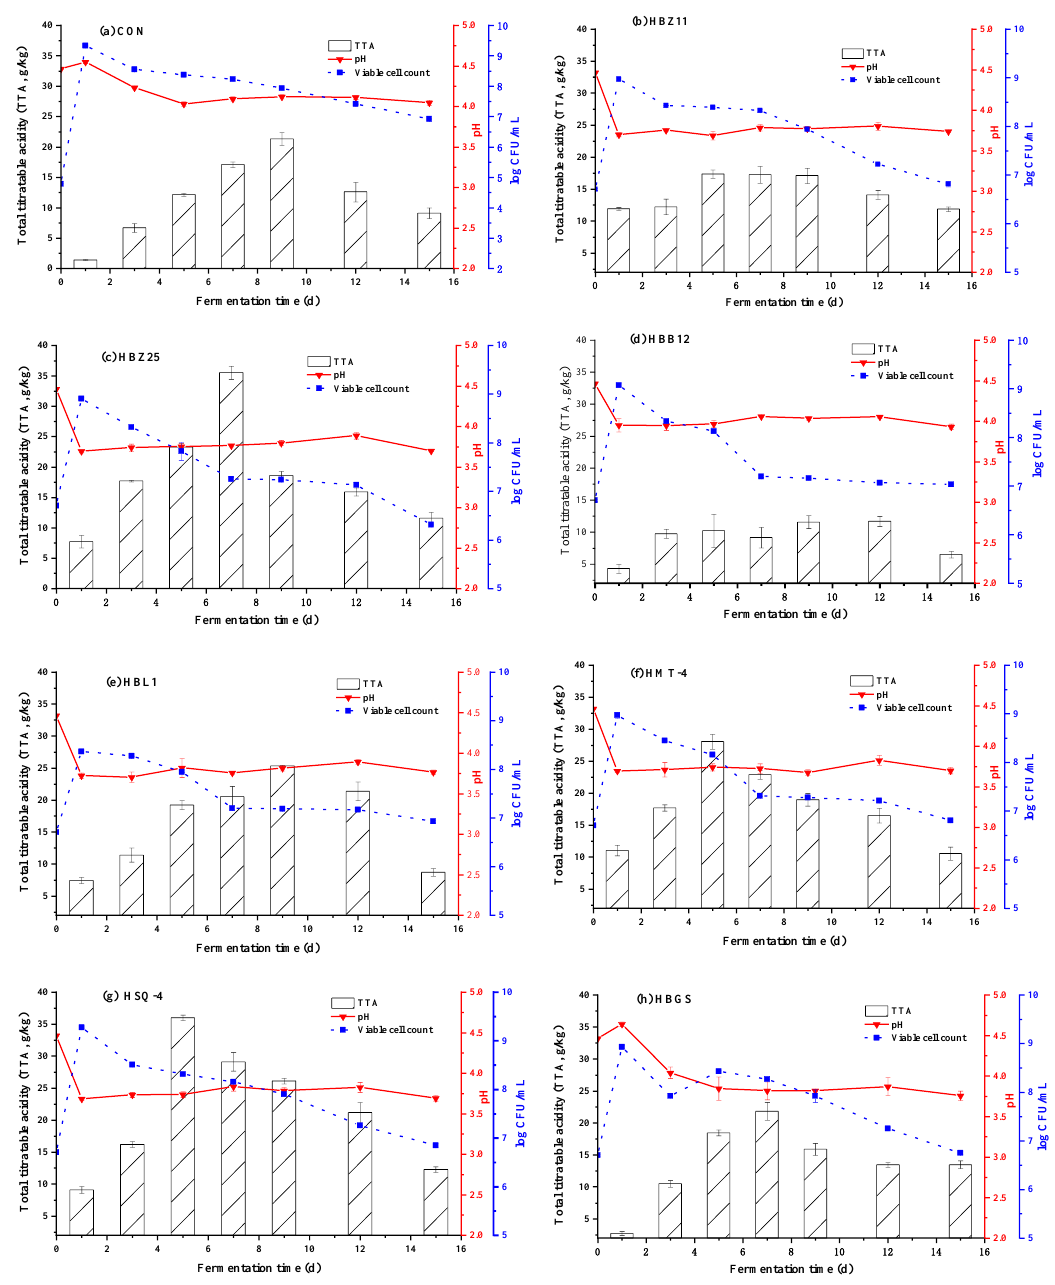
Figure 1. The changes of pH, total titration acid, and viable count during the preparation of HST: ( a ) CON (HST prepared by natural fermentation of pasteurized HST materials); ( b ) HBZ11; ( c ) HBZ25; ( d ) HBB12; ( e ) HBL1; ( f ) HMT-4; ( g ) HSQ-4; ( h ) HBGS. CON indicated HST prepared by natural fermentation of pasteurized HST materials. HBZ11, HBZ25, HSQ-4, HMT-4, HBGS, HBL1, and HBB12 were HST prepared with starter cultures Bifidobacterium animalis subsp. lactis BZ11, Bifidobacterium animalis subsp. lactis BZ25, Lactiplantibacillus plantarum SQ-4, Lactiplantibacillus pen- tosus MT-4, Lactobacillus bulgaricus , Bifidobacterium longum BL1, and B ifidobacterium animalis subsp. lactis BB12, respectively.